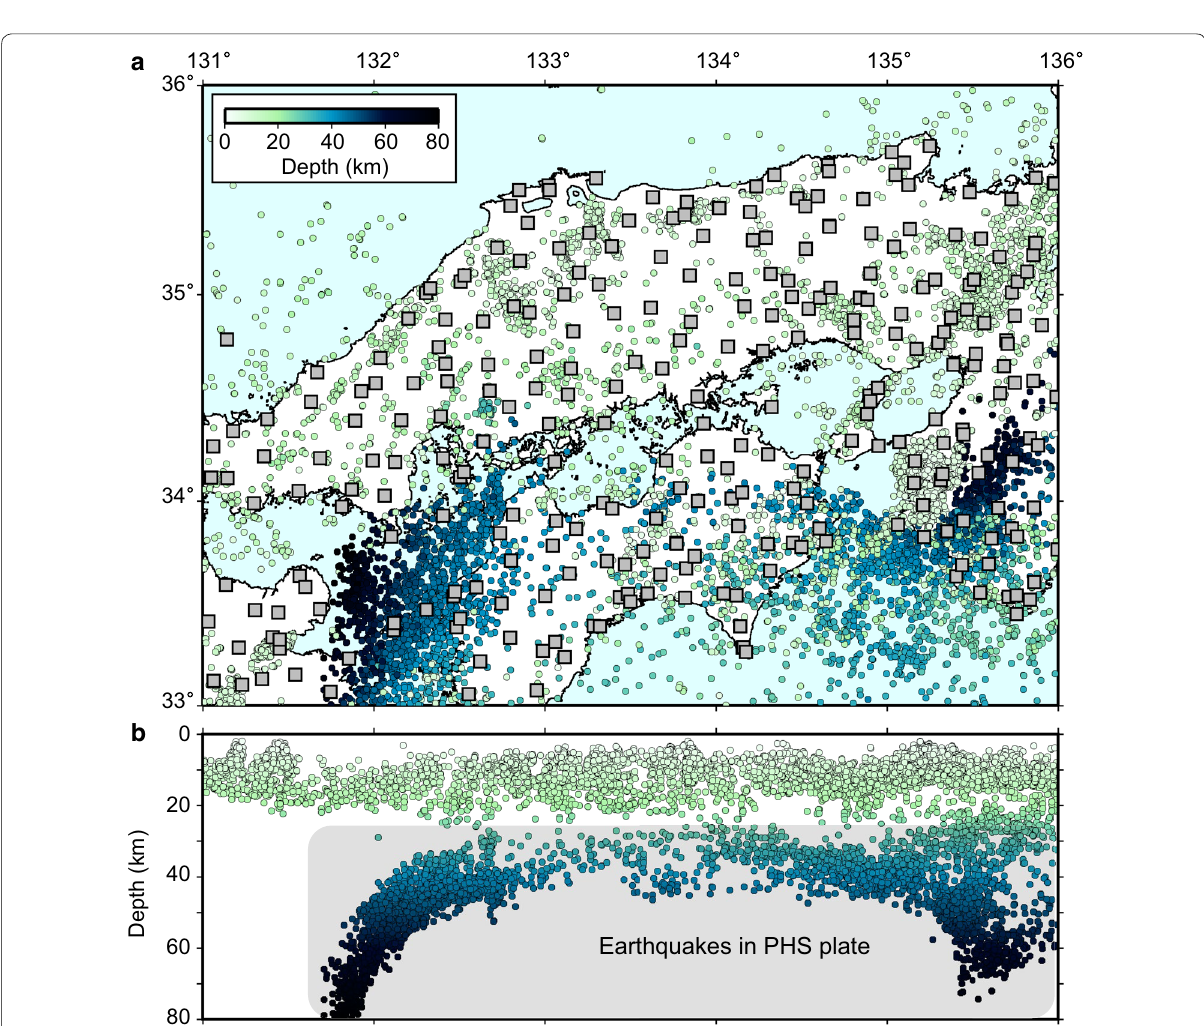
Fig. 2 a Distribution of earthquakes (circles) and stations (gray squares) considered in this study. Colors represent the depths of the earthquakes. b Depth distribution of the hypocenters projected on vertical cross-section in the east–west